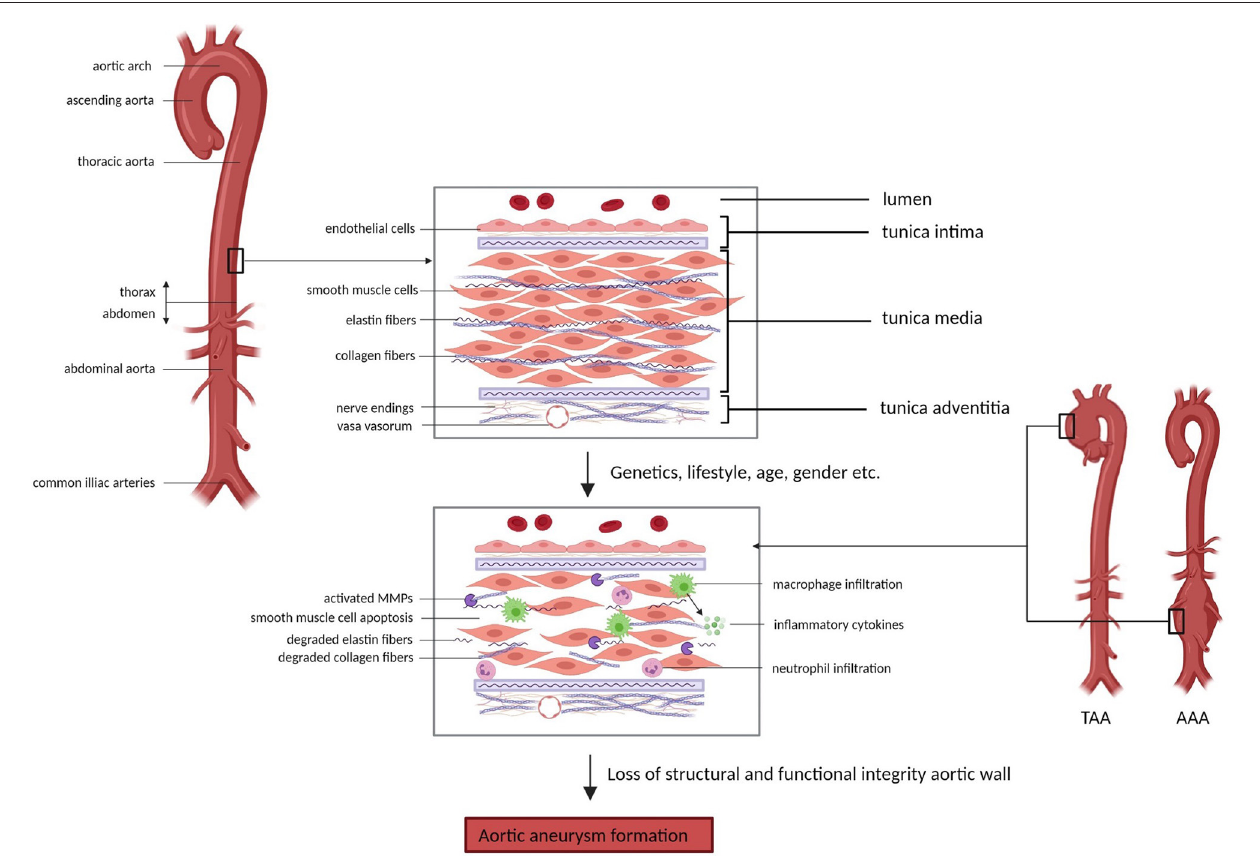
FIGURE 1 | Aortic wall changes in aortic aneurysm formation. The aortic wall comprises three layers; the inner tunica intima, the middle tunica media and the outer tunica adventitia, which contain different cell types (e.g. endothelial cells and smooth muscle cells) and structures (e.g. elastin fibers and collagen fibers) that are essential in the maintenance of the structural integrity and function of the aorta. Factors such as genetics, lifestyle, age and gender can contribute to impairment of the structure and function of the aortic wall, eventually causing aortic aneurysm formation. Underlying processes involved in aneurysm development include smooth muscle cell apoptosis, degradation of extracellular matrix components and inflammation. AAA = abdominal aortic aneurysm, TAA = thoracic aortic aneurysm, MMPs = matrix metalloproteinases (Picture created with